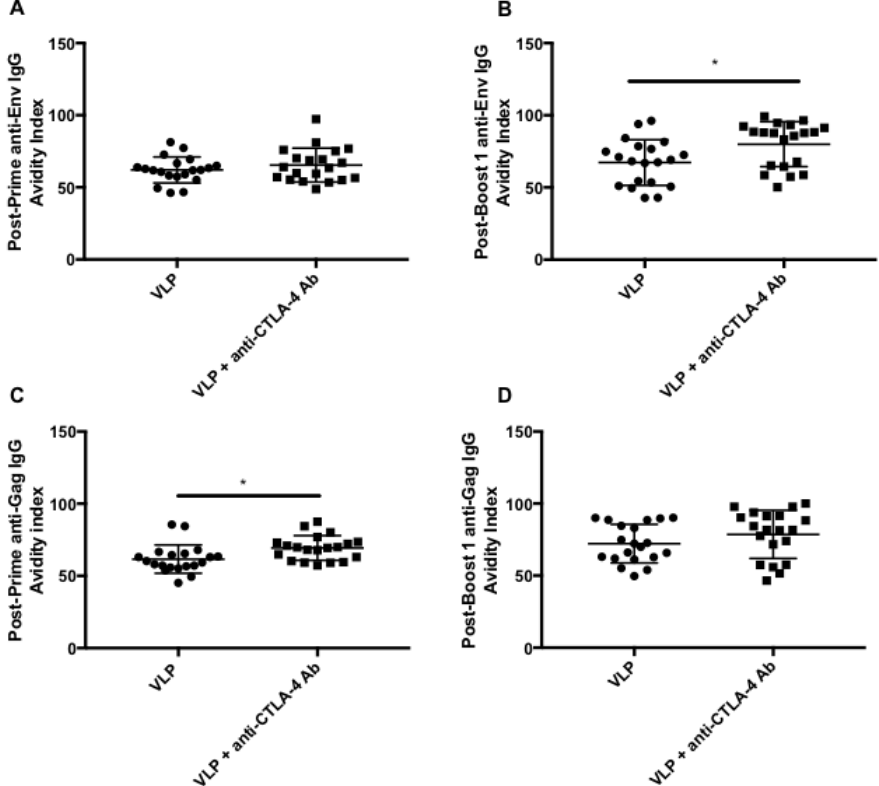
Figure 6. CTLA-4 blockade increases the avidity of HIV-specific antibody responses. The avidity index of serum from Cohorts 1 and 2 ( n = 30) was analyzed through a urea-based avidity assay. ( A ) Post-prime anti-Env IgG avidity index; ( B ) Post-boost 1 anti-Env IgG avidity index; ( C ) Post-prime anti-Gag IgG avidity index; ( D ) Post-boost 1 anti-Gag IgG avidity. Significance was determined by an unpaired T-test. * p < 0.05. Data is representative of two independent experiments.